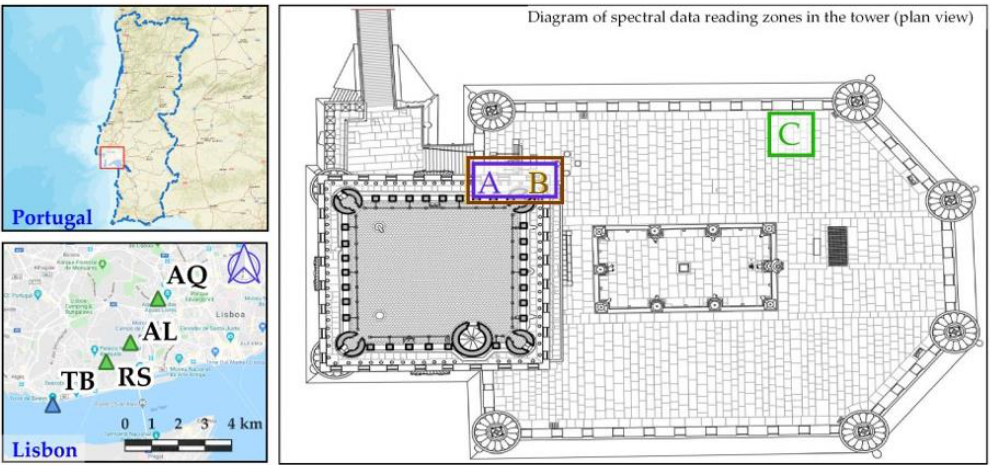
Figure 2. (Left) Location of the Tower of Belém (TB) and of the old Lioz quarries of Rio Seco (RS), Alvito (AL) and Aqueduto das Á guas Livres (AQ). (Right) Location of spectral data reading zones in the Tower: A (purple) data acquisition of original Lioz with hyperspectral camera. B (brown) data acquisition of original Lioz with spectroradiometer. C (green) data acquisition of silica (dark spots) with spectroradiometer in an ashlar of the Tower.